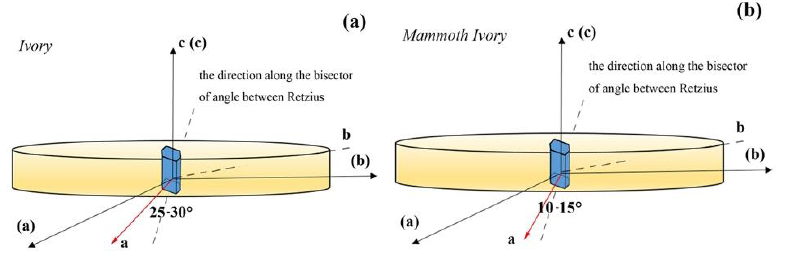
Figure 11. Crystallographic orientation of hydroxyapatite: ( a ) ivory, ( b ) mammoth ivory.